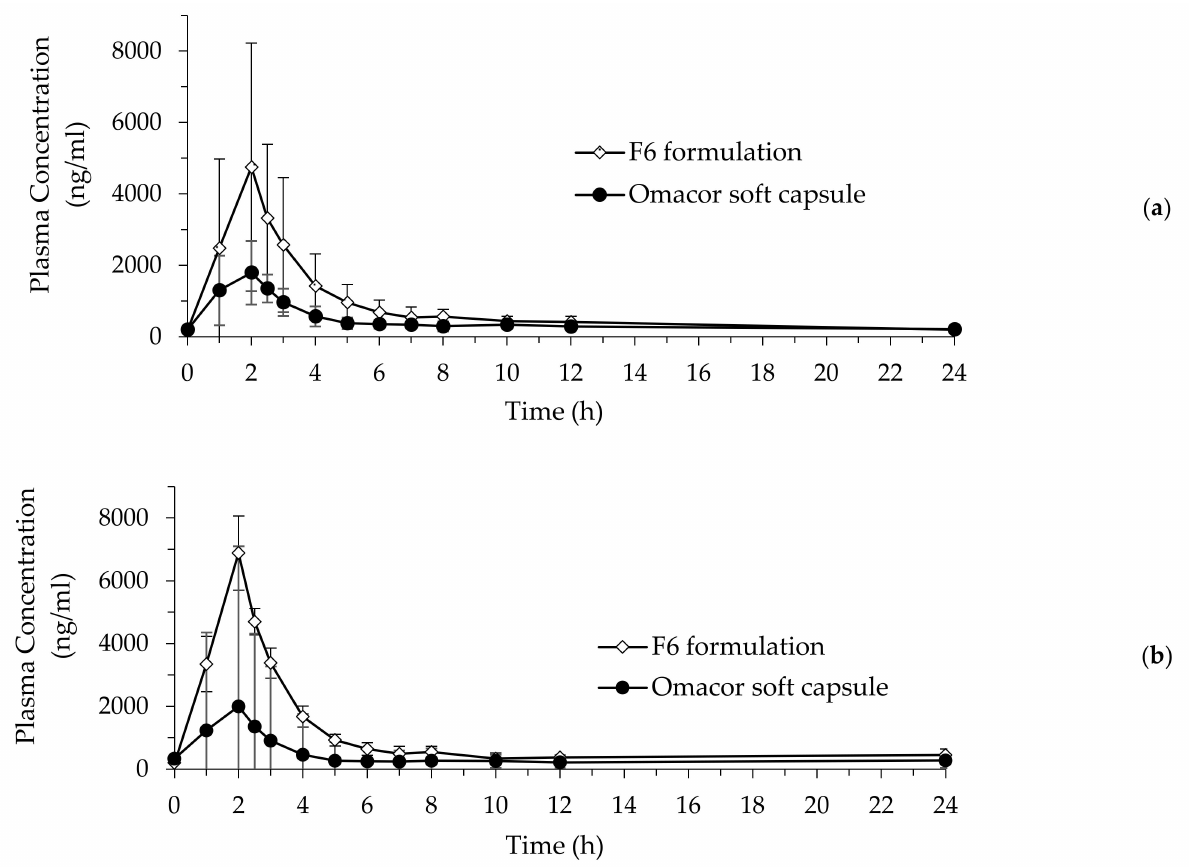
Figure 6. Plasma concentration time profile of SALCs (F6 formulation) and the reference (Omacor soft capsules) after oral administration of a 1000 mg single-dose of Ω -3 EE in male beagle dogs ( n = 5). ( a ) Plasma concentration of EPA in SALCs and the reference; ( b ) Plasma concentration of DHA in SALCs and the reference. Abbreviations: EPA, eicosapentaenoic acid; DHA, docosahexaenoic